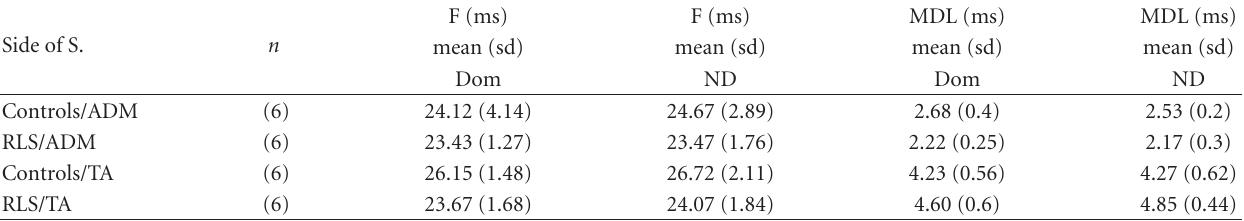
Table 2: F-wave (F) and motor distal latency (MDL) measured in the dominant (Dom) and non-dominant (ND) abductor digiti minimi (ADM) and tibialis anterior (TA) muscles did not di ff er significantly between subjects with RLS and controls (CTR). Side of